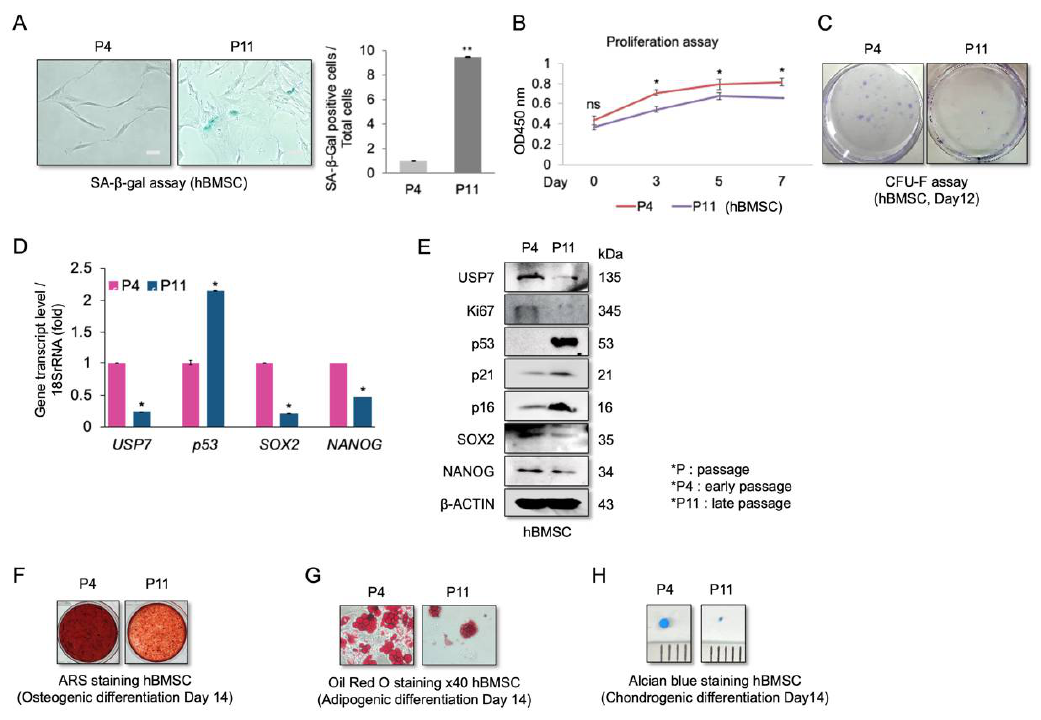
Figure 1. Analysis of self-renewal, multilineage differentiation potential, and USP7 expression in early and late passage hBMSCs. ( A ) Senescence-associated-β-gal (SA-β-gal) activity investigated in passage 4 (P4) and passage 11 (P11) hBMSCs. Scale bar = 30 μm. ( B ) Proliferation rates of P4 and P11 cells measured using the cell viability assay. ( C ) Colony-forming capacities of P4 and P11 cells measured using CFU-F. ( D ) qRT-PCR and ( E ) immunoblot analysis results for USP7, proliferation marker Ki67, aging markers p53, p21, and p16, and self-renewal markers SOX2 and NANOG. ( F ) Alizarin red S stained P4 and P11 cells after 14 days of osteogenic differentiations. ( G ) Oil red O stained P4 and P11 cells cultured in adipogenic medium for 14 days. Scale bars for the original magnification × 40 = 30 μm. ( H ) Alcian blue stained P4 and P11 micro-mass pellets cultured in chondrogenic medium for 14 days. Data are presented as mean ± SD. ns; not significant, * p < 0.05, ** p < 0.01. n = 3.